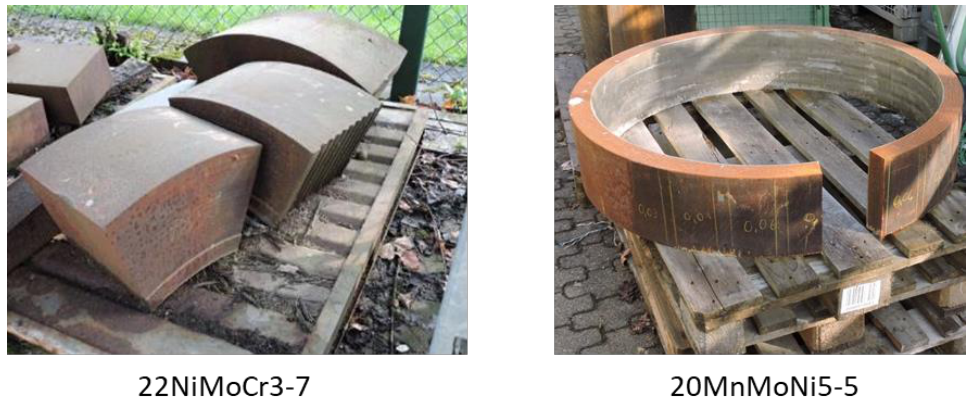
Figure 1. Reactor components provided by Fraunhofer IWM.